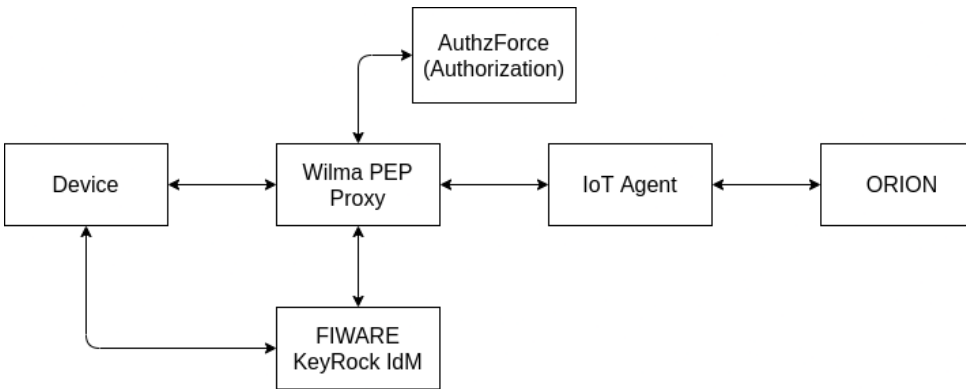
Figure 6. Simplified representation of the standard authentication FIWARE